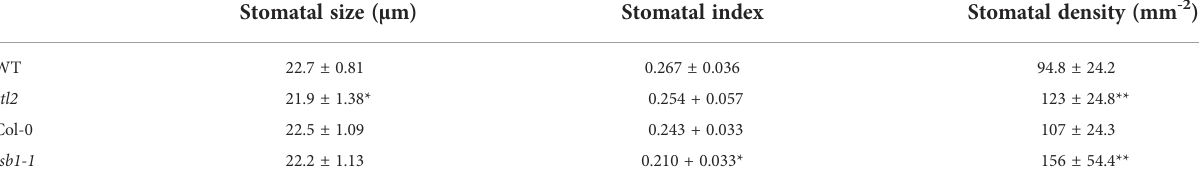
TABLE 1 Stomatal size, index and density in plants.